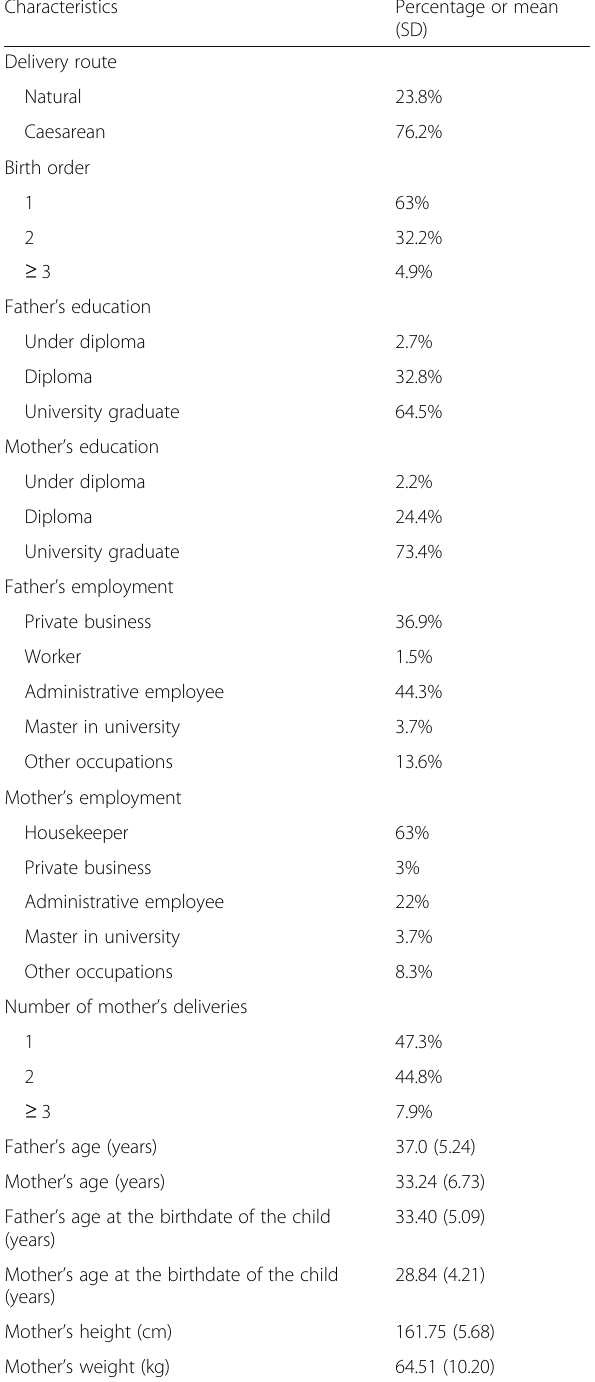
Table 1 Characteristics of studied participants